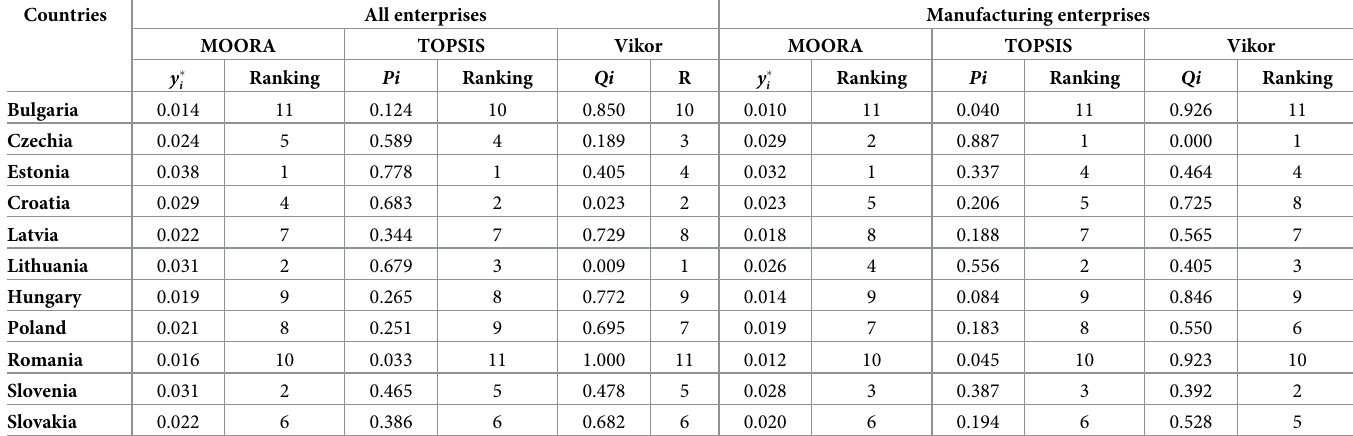
Table 10. Values of indices classifying the digital maturity among all and manufacturing enterprises by the MOORA, TOPSIS and VIKOR methods for the CEE countries.